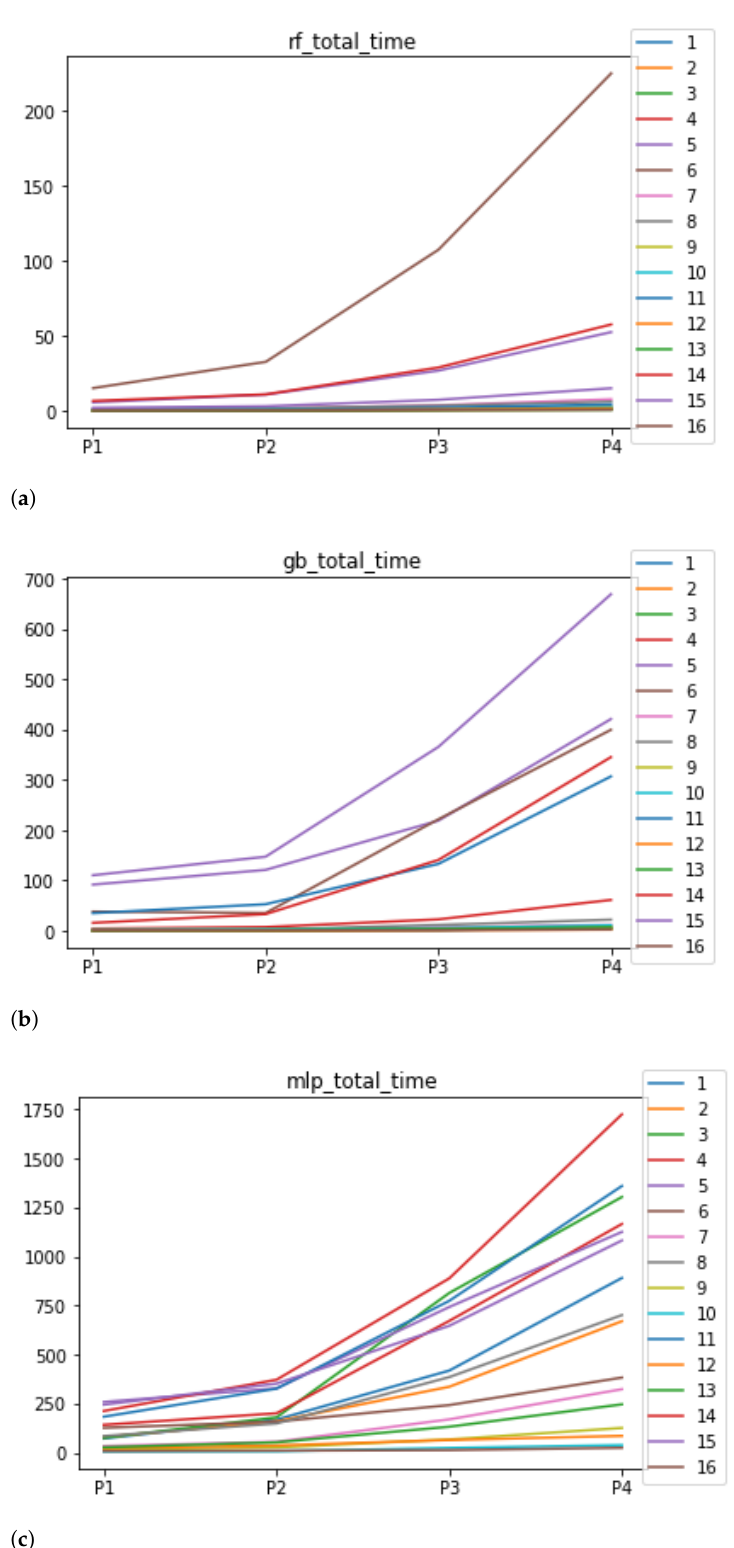
Figure 6. Behavior of RHOASo: time complexity. Each line represents a dataset. ( a ) Time complexity for RF. Axis X: the partition of the dataset. Axis Y: the obtained time complexity in seconds. ( b ) Time complexity for GB. Axis X: the partition of the dataset. Axis Y: the obtained time complexity in seconds. ( c ) Time complexity for MLP. Axis X: the partition of the dataset. Axis Y: the obtained time complexity in